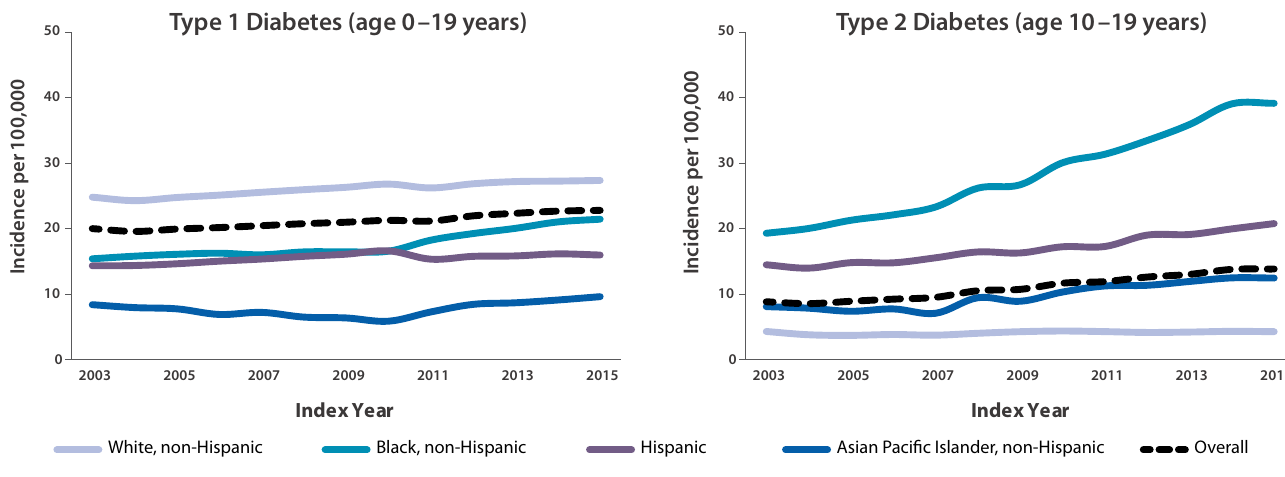
Figure 5. Trends in incidence of type 1 and type 2 diabetes in youth, overall and by race/ethnicity, 2002–2015